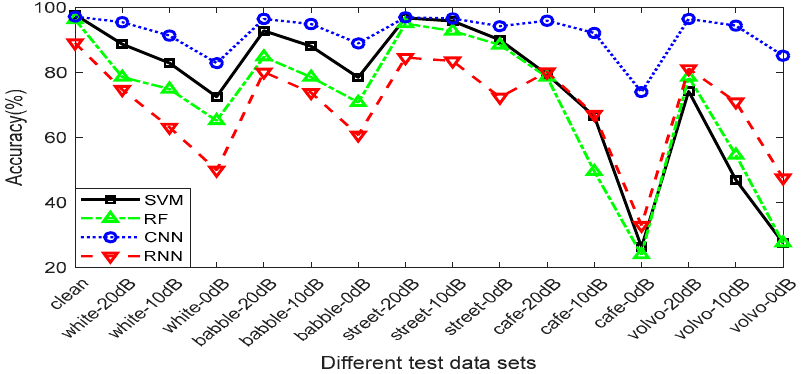
Figure 9. Comparison of accuracy of different classifiers using SSF (CQT).